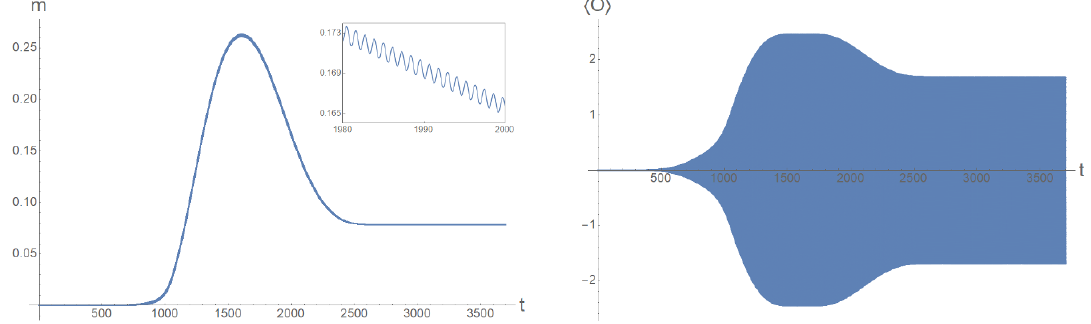
Figure 36 . Time evolution of m and hOi along the quench described in the main text. The blue region corresponds to a highly dense number of fast oscillations compared with the duration of the process. In the (cid:12)rst plot this region is not appreciated but as the inset shows it is also present. two di(cid:11)erent late-time phases, as for the complex scalar (cid:12)eld. Furthermore, as (cid:12) ! (cid:12) system seems to spend progressively larger time around an intermediate